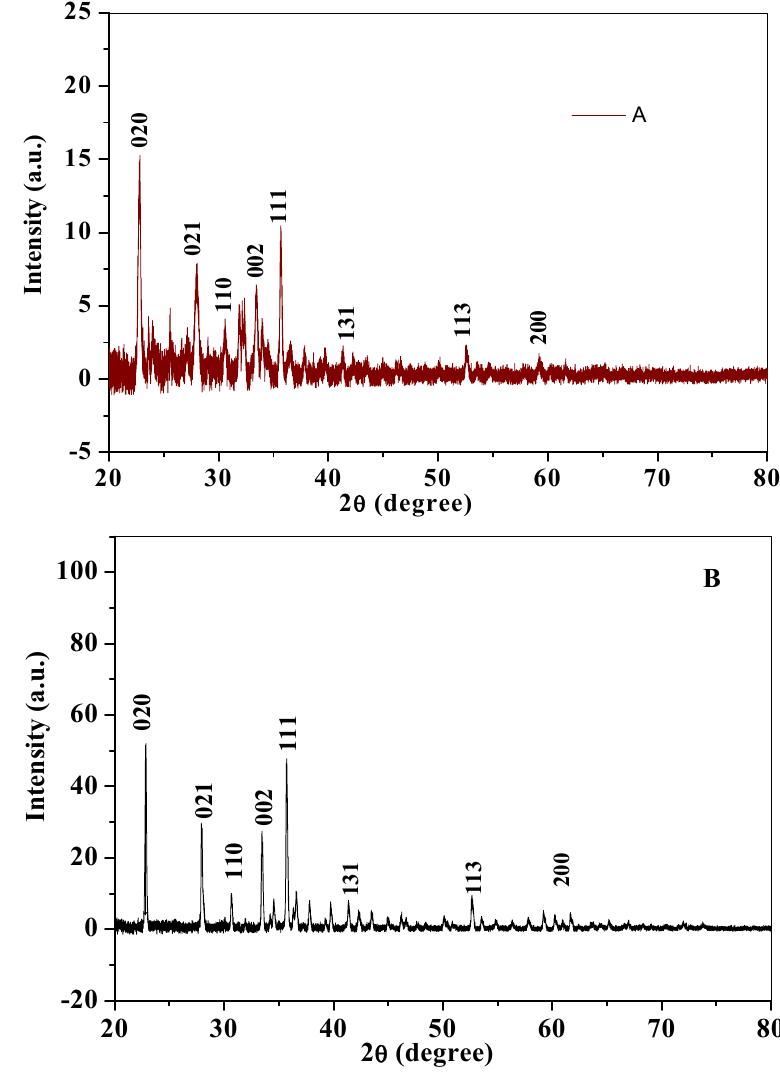
Figure 5. X-ray di ff ractograms of ( A ) cCuO and ( B ) Figure 5. X-ray diffractograms of ( A ) cCuO and ( B ) wCuO. Table 1. d-inter planar spacing calculations for CuONP.